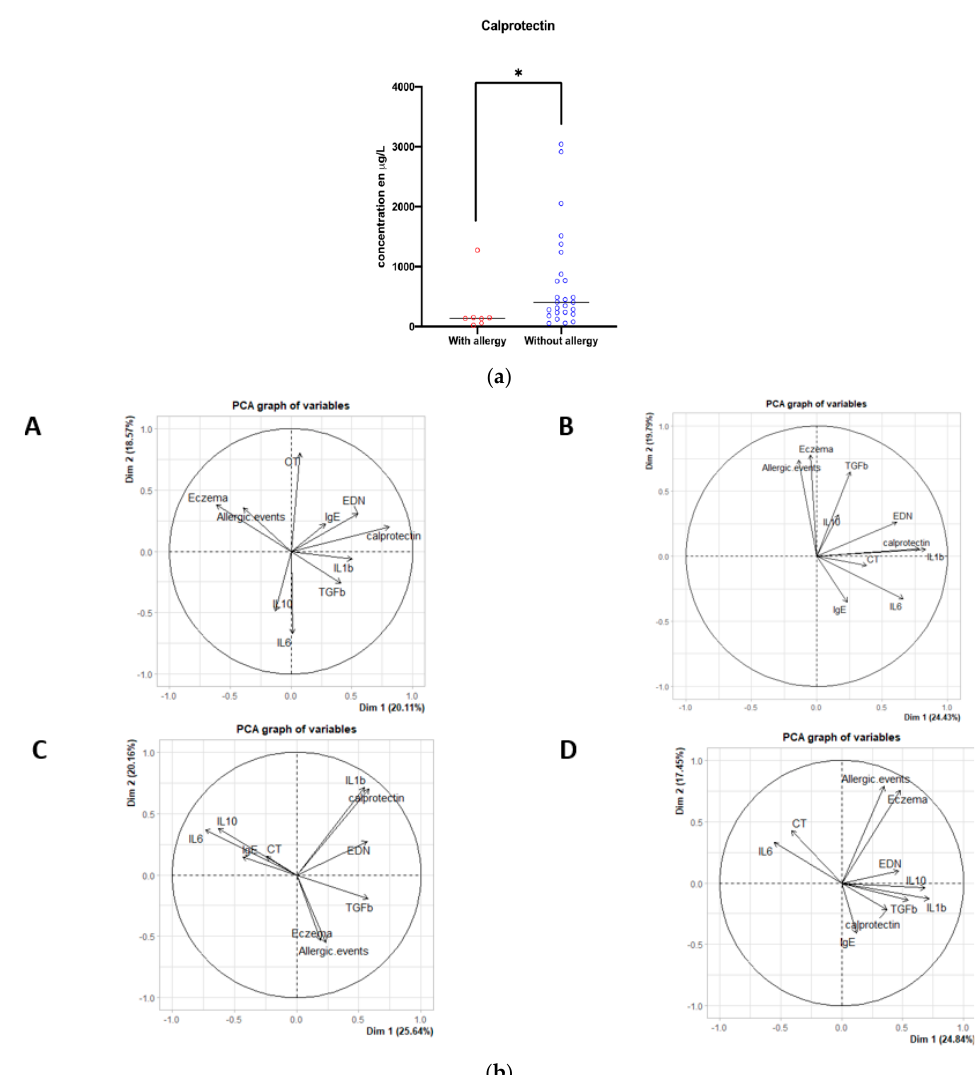
Figure 4. ( a ). Comparison of meconial calprotectin concentration according to the later occurrence of asthma or cow’s milk allergy. ( b ). Principal component analysis of neonatal immune and archaeal biomarkers as a function of later occurrence of atopic conditions. ( A ) Negative and significant ( p < 0.001) correlation (r = − 0.64) between the occurrence of atopic dermatitis with calprotectin, EDN, and IL-1 β . Strong positive and significant correlation ( p < 0.01) between calprotectin (r = 0.79), EDN (0.53), and IL-1b (0.51). No correlation between Archaea TCs and other parameters. ( B ) Correlation between allergic events (asthma or cow’s milk allergy) and atopic dermatitis. Strong positive and significant ( p < 0.001) correlation between IL-1b (r = 0.88) and calprotectin (r = 0.82), positive cor- relation between IL-6 (r = 0.62) and EDN (r = 0.59), significant ( p < 0.001). Low positive (r < 0.5) and significant correlation between Archaea TCs and biomarkers IL-1b, calprotectin, IL-6, and EDN. ( C ) Positive and significant correlation ( p < 0.001) between atopic dermatitis, allergic events with the markers calprotectin (r = 0.61), IL-1b (r = 0.58), EDN (r = 0.57), and TGF- β (r = 0.57). Negative correlation between IL-6 (r = − 0.71) and IL-10 (r = − 0.61) with atopic dermatitis and allergic events. Positive and significant correlation between Archaea TCs with calprotectin, IL-1b, IL-6, and EDN. Negative correlation between Archaea Ct and allergic events. ( D ) Negative correlation between IL-6 (r = − 0.51) with other biomarkers and allergic events. Strong positive and significant correlation ( p < 0.001) between IL-1b (r = 0.68), IL-10 (r = 0.67), and atopic dermatitis (r = 0.58). Low correlation (r < 0.5) between Archaea TCs with IL-1 β , calprotectin, IL-6, and EDN. Negative correlation between allergic events and TC of